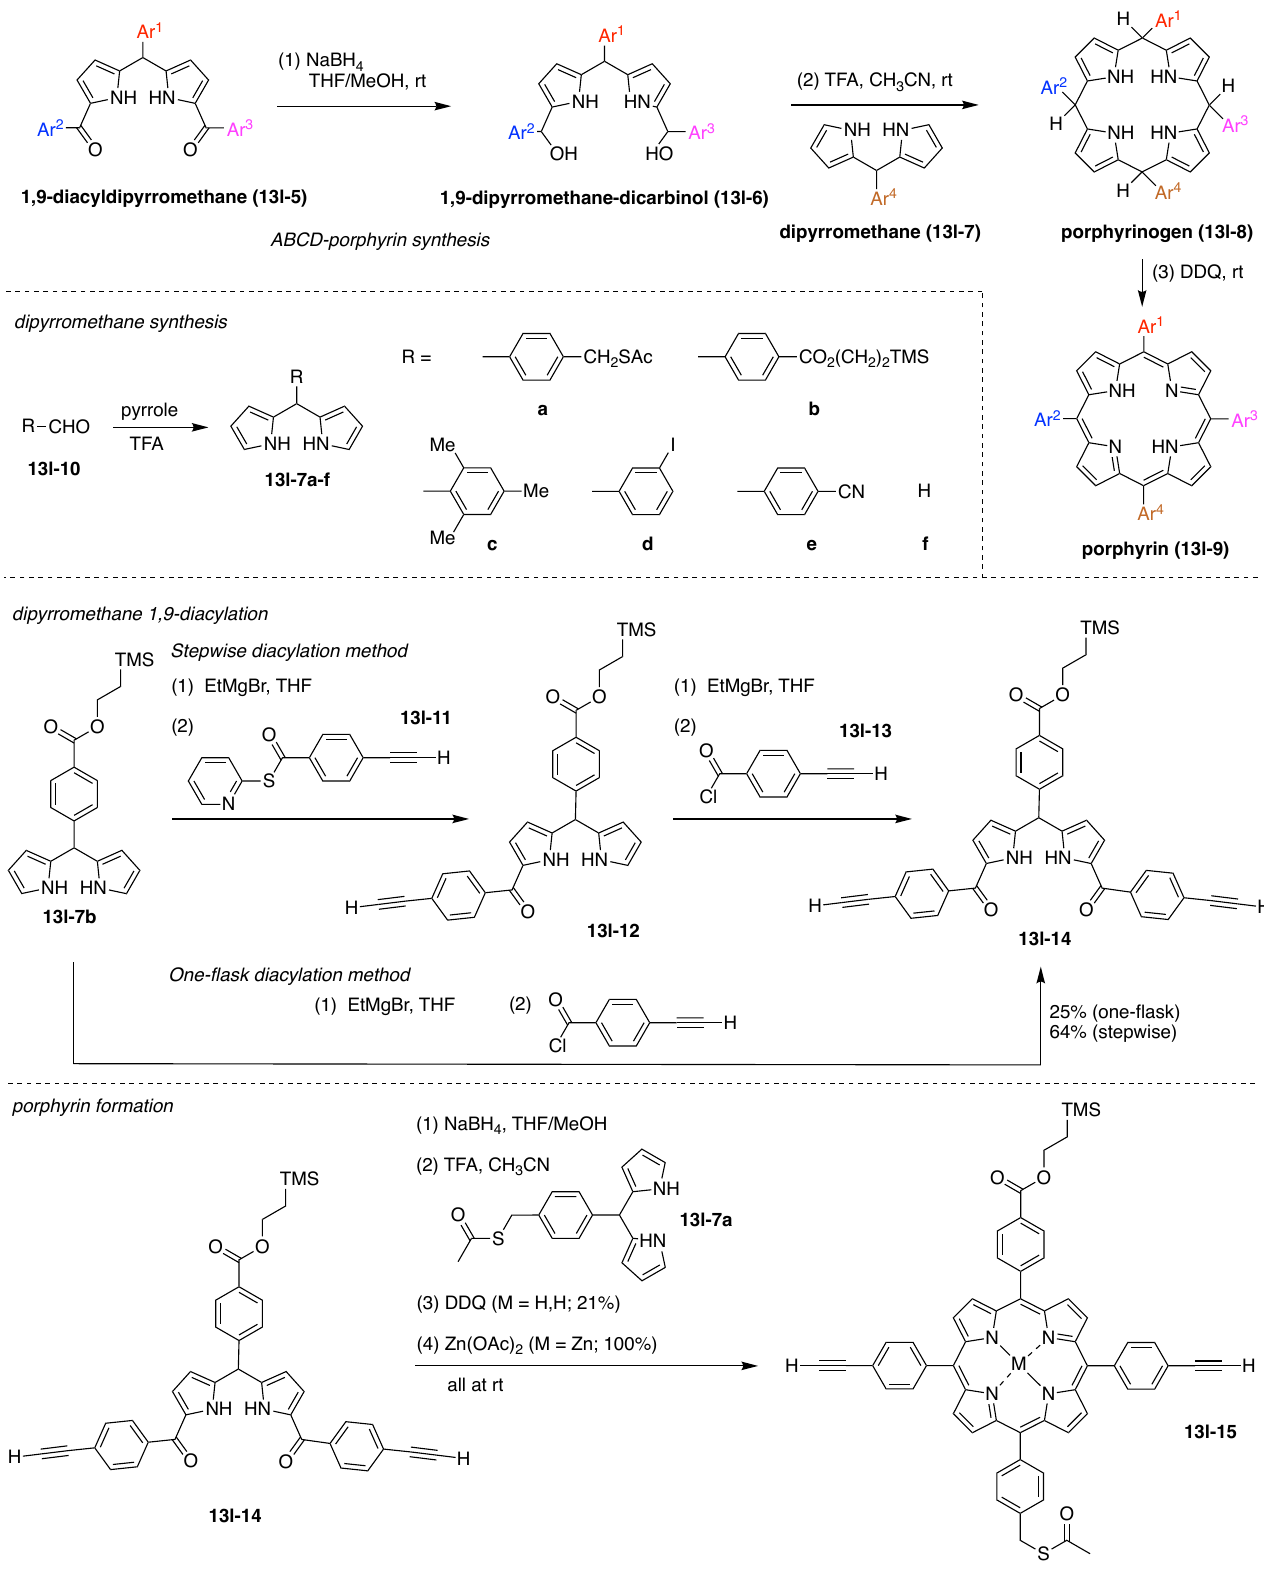
Figure 75. Rational synthesis of porphyrins with four distinct meso-substituents ( top panel ). One-flask synthesis of dipyrromethanes ( second panel ). Synthesis of 1,9-diacyldipyrromethanes ( third panel ). Use of a 1,9-diacyldipyrromethane and a dipyrromethane to form a porphyrin bearing two ethynes, one protected ester, and one S -acetylthioether ( bottom panel ).